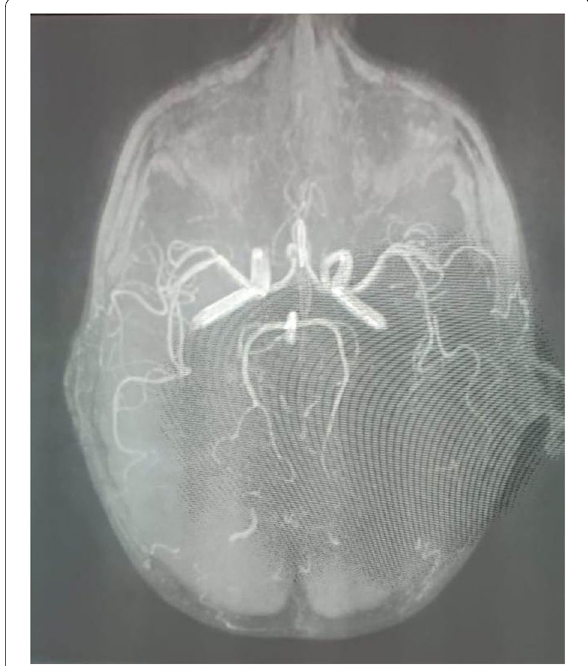
Fig. 2 MRI angiogram of the brain showing bilateral middle cerebral artery (MCA) and posterior cerebral artery (PCA) normal in all segments (M1, M2, M3, and M4) and (P1, P2, P3, P4) respectively, shows normal course and calibre and no filling defect